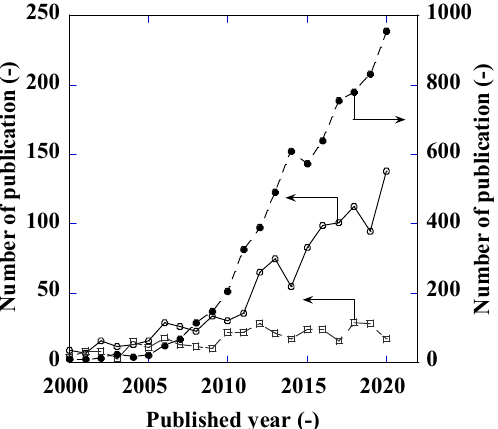
Figure 2. Number of publications surveyed by Google Scholar on the 3 June 2021. The keywords used for the survey are as follows: ● , thermotolerant and bioethanol; ○ , dehydration, membrane, separation, bioethanol, and hybrid process; □ , ethanol selective, membrane, and separation.